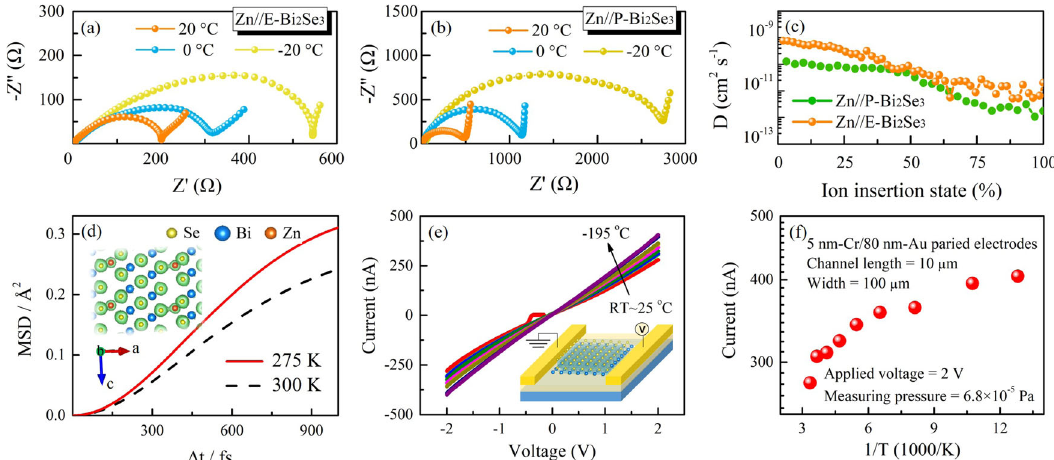
Fig. 6 Study of the low-temperature electronic conductivity and ion diffusion kinetics of E-Bi 2 Se 3 cathode. EIS of the a Zn||E-Bi 2 Se 3 and b Zn||P-Bi 2 Se 3 cells, obtained at − 20, 0, and 20 °C. c Diffusivity coef fi cient (D) of Zn 2 + , calculated using the GITT, of Zn||E-Bi 2 Se 3 and Zn||P-Bi 2 Se 3 cells in the third cycle at 25 °C. d MSD of the Zn between 4 × 4 × 1 supercell Bi 2 Se 3 bilayers, as discovered using ab initio MD simulation at 275 and 300 K, respectively. The inset displays electron density plot for the Zn x Bi 2 Se 3 skeleton. e I – V curves of Zn x Bi 2 Se 3 with inset showing schematic of the Zn x Bi 2 Se 3 nanosheet device fabricated for the electrical transport experiment and f the corresponding temperature-dependent current analysis on the Zn x Bi 2 Se 3